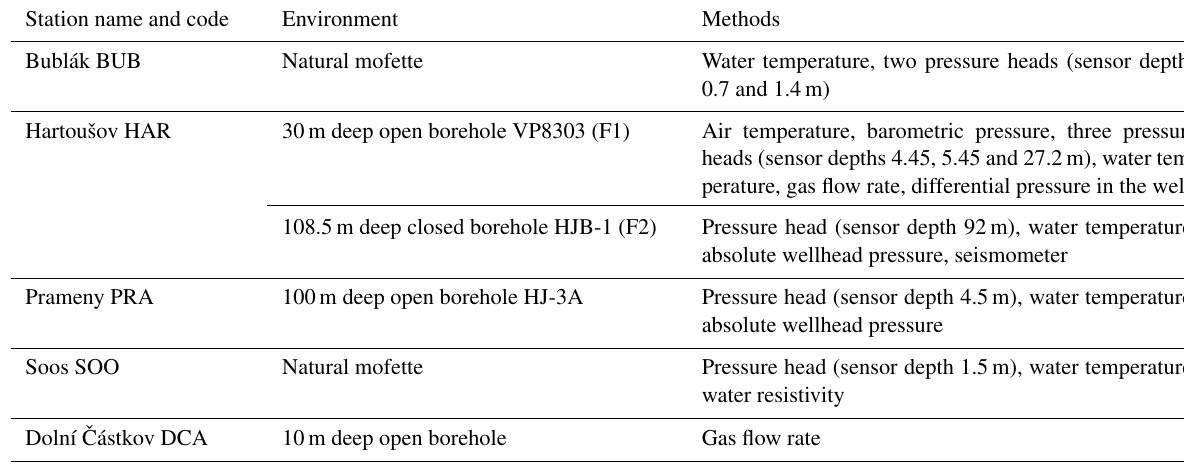
Table 1. CarbonNet monitoring